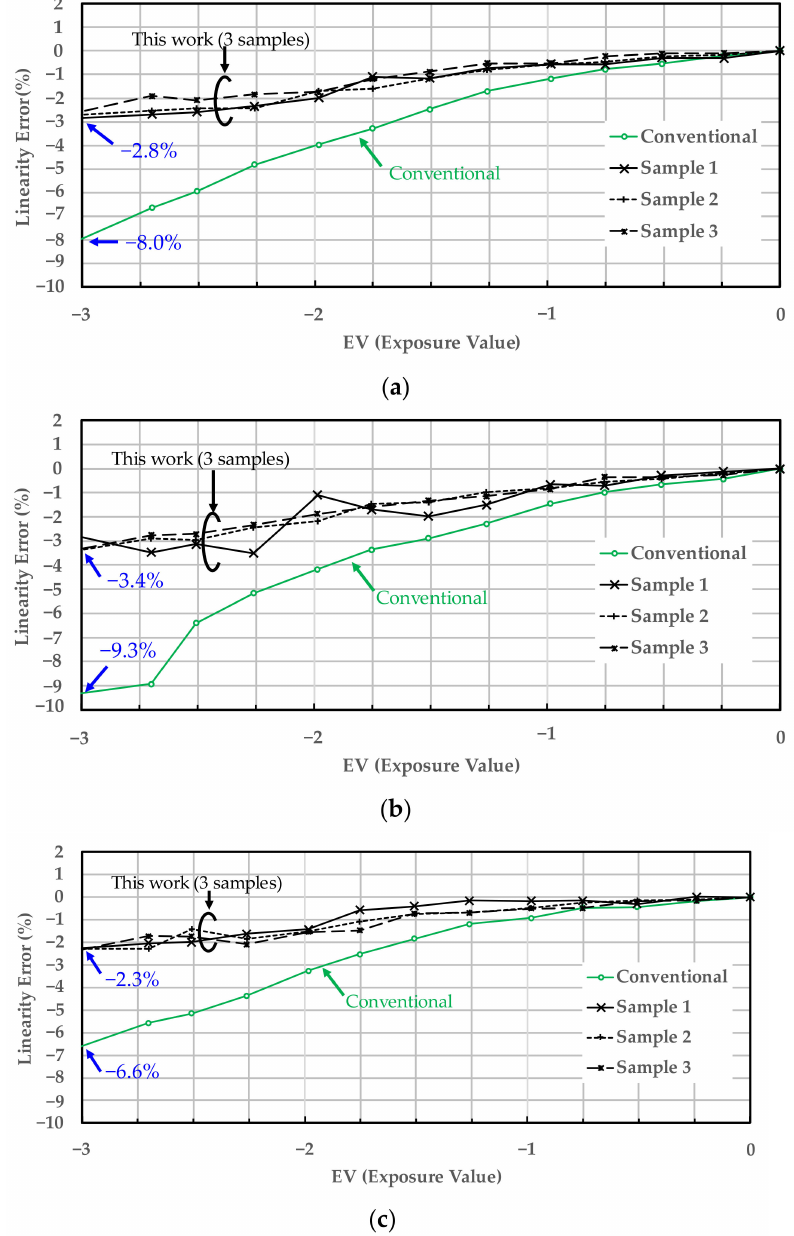
Figure 17. Comparison of sensor linearity error under low-light conditions between the conventional and proposed circuit. ( a – c ) show the evaluation result at typical, minimum, and maximum operating voltage,